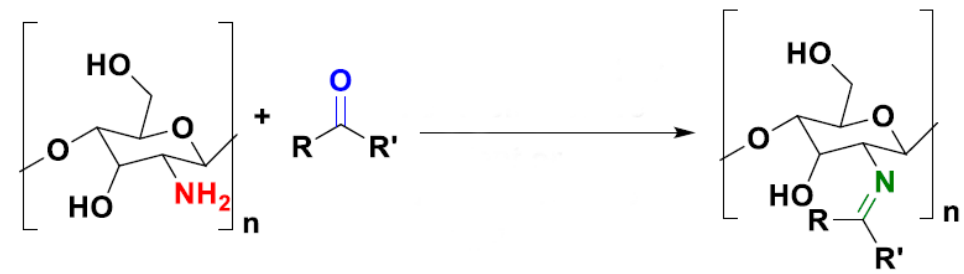
Figure 1. Chemical modification of chitosan via imine functionalization.